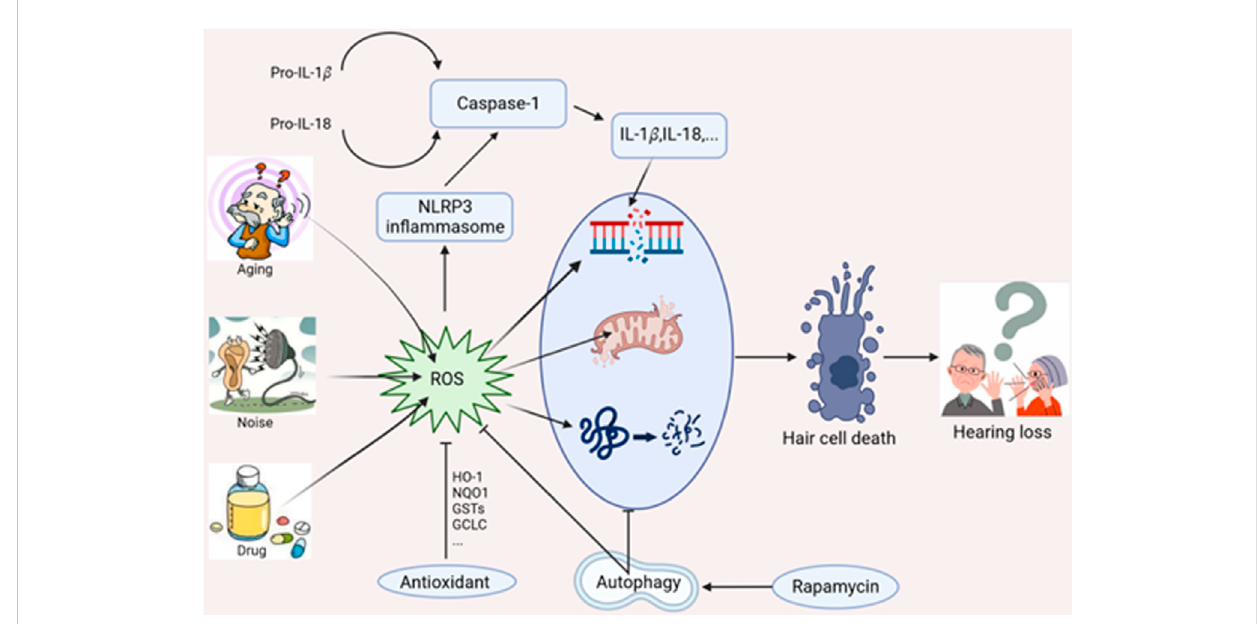
FIGURE 1 Interplay of oxidative stress, autophagy and NLRP3 in fl ammasome in hearing